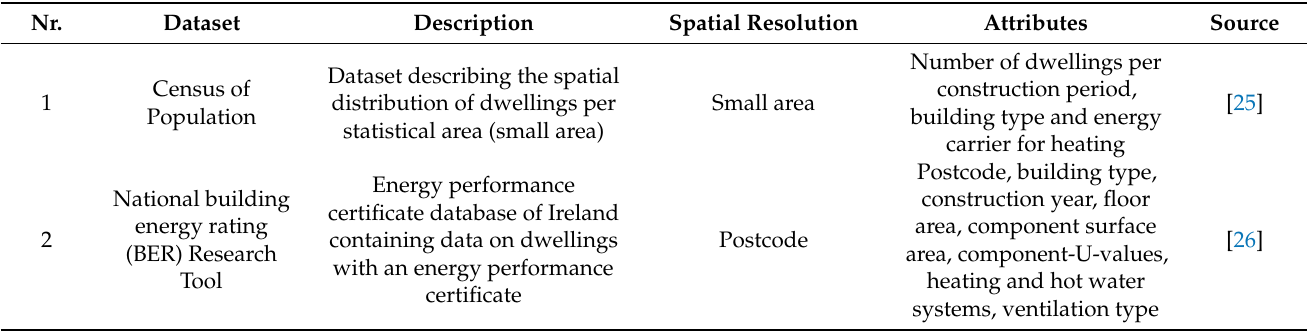
Table 1. Overview input data for